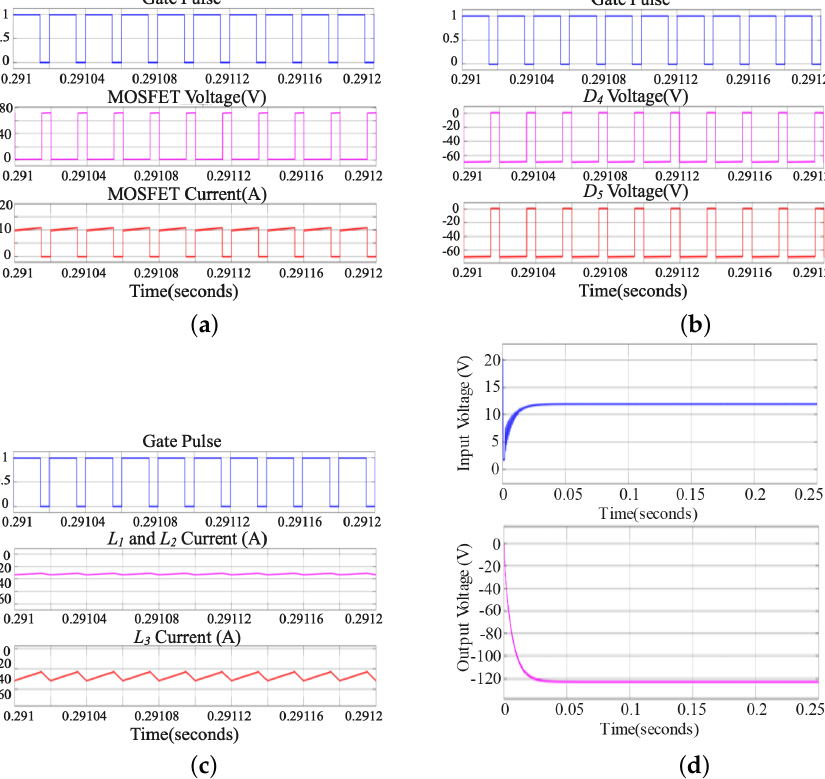
Figure 10. Simulation results of topology 1: ( a ) voltage and current of MOSFET ( b ) voltage across diodes ( c ) inductor’s current ( d ) input and output